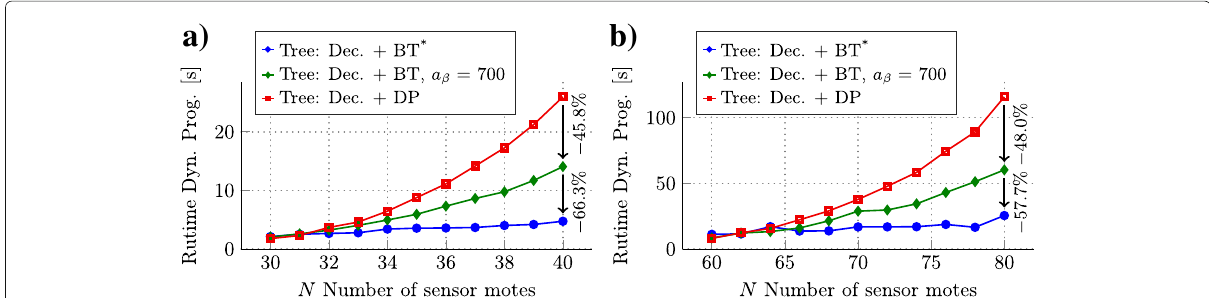
Fig. 10 Figures a and b show the run times of the dynamic programming part for 10 and 20 distinct DS-CDMA codes, respectively. The measurement noise and sensing range have been set to σ = 0.05 and R =